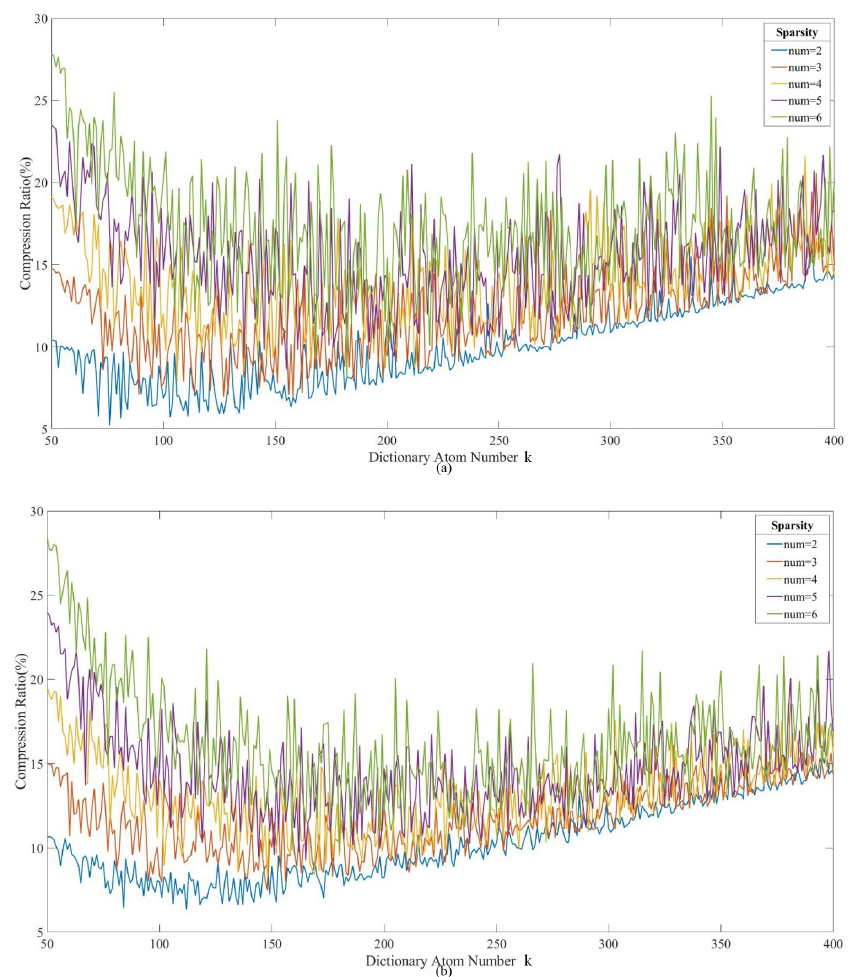
Figure 5. The effect of dictionary atom number k and sparsity T on compression ratio δ comp (( a ) is 10.95° N, 112.95° E; ( b ) is 0.95° N, 4.95° E). Figure 5 is the compression result of dictionary learning with two selected